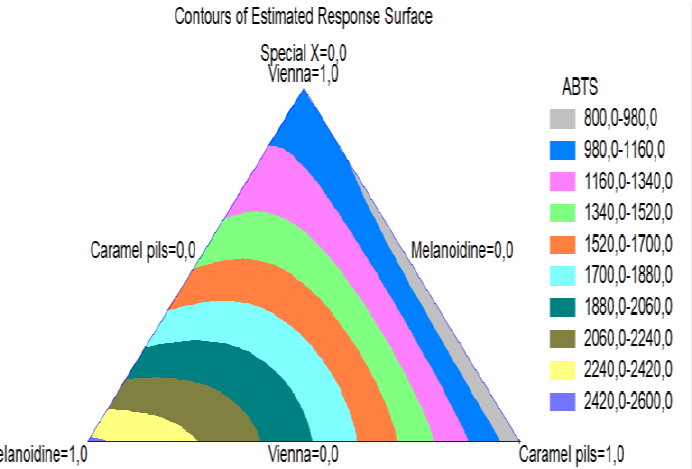
Figure 6. Effect of mixture composition on the antio × idant activity, measured by FRAP method. (the “,” character represents a decimal point).